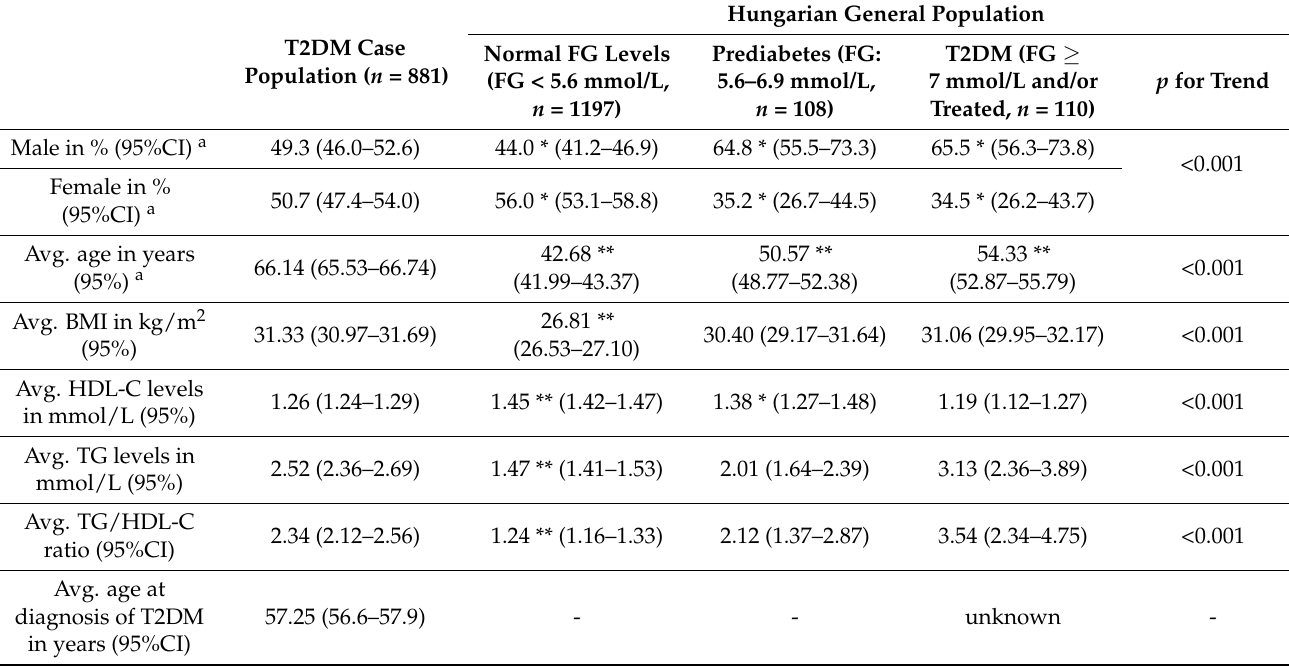
Table 1. Characteristics of the T2DM case and the Hungarian general population by three categories.